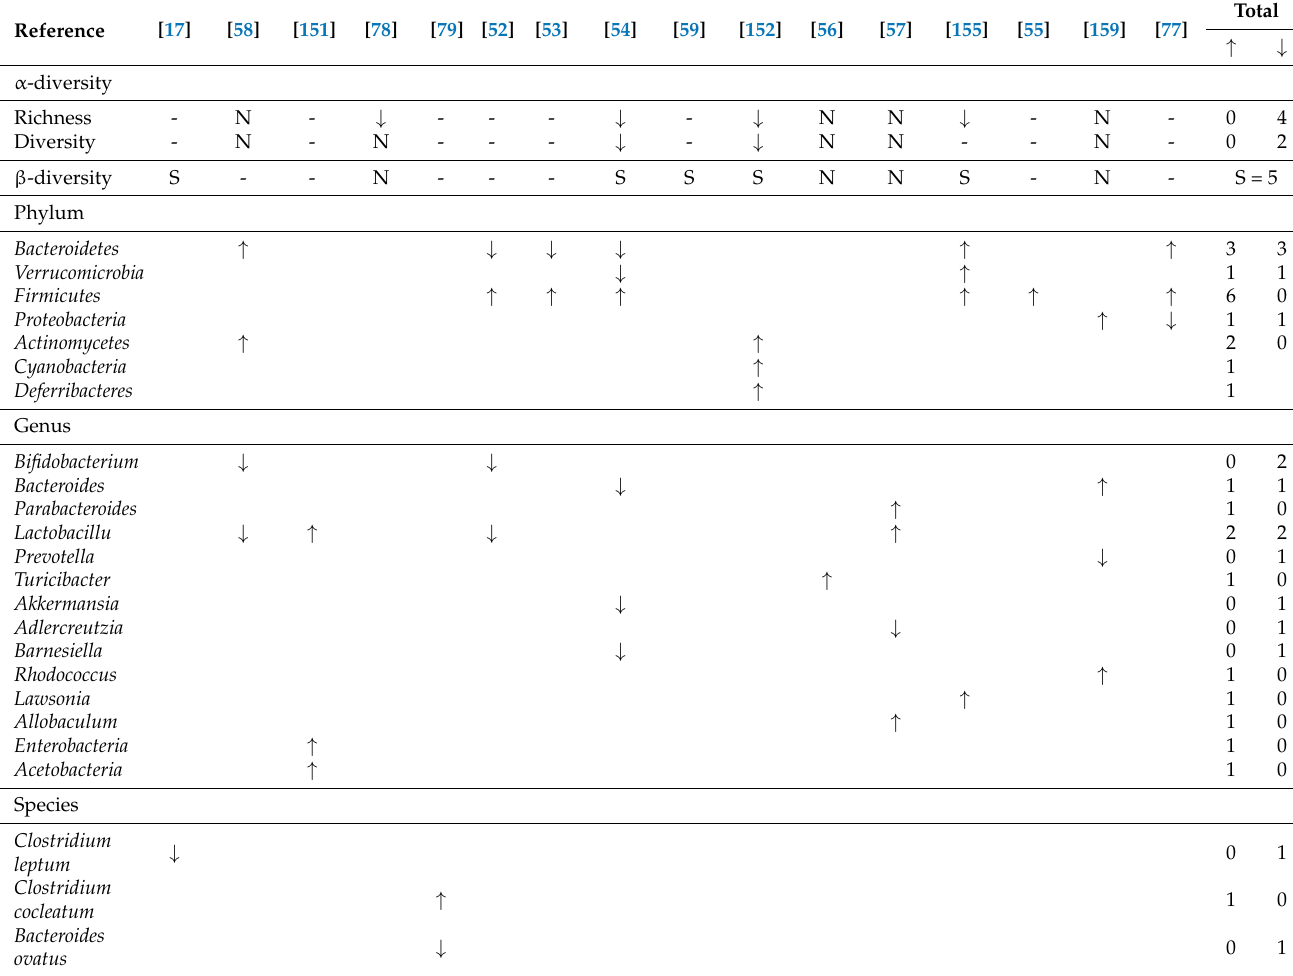
Table 4. The impact of titanium dioxide nanoparticles on gut